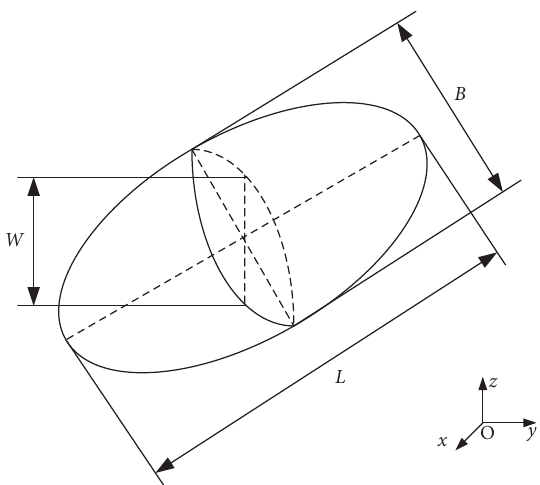
Figure 3: Ellipsoid drop with the major axis of length L and two minor axes of lengths B and W